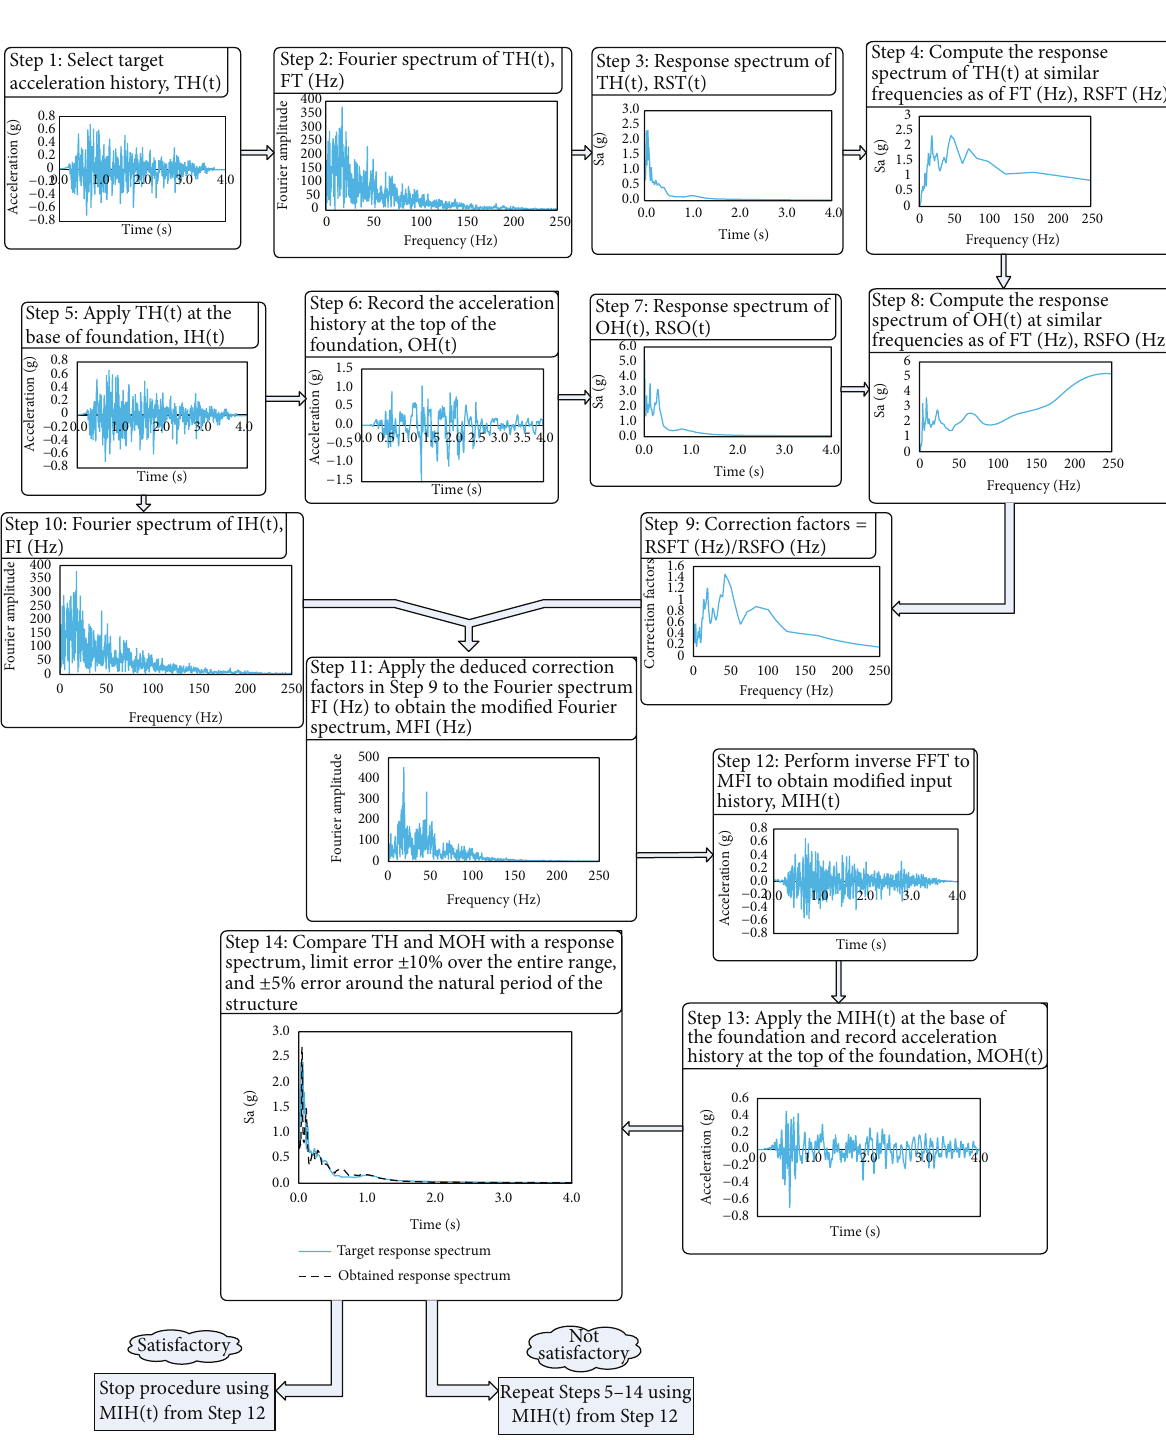
Figure 2: Proposed deconvolution